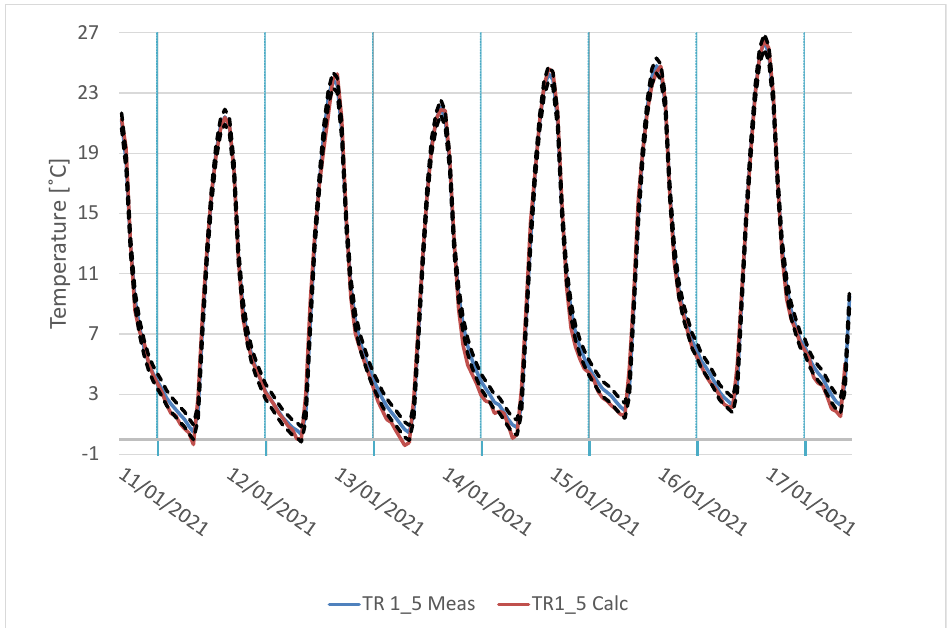
Figure 19. Cell 1. Winter. Grid open. Temperatures of the exterior face of the outer slab in Zone 4: measured ( ) and calculated ( ). Bands of ± 0.5 ◦ C, ( ), are shown.)